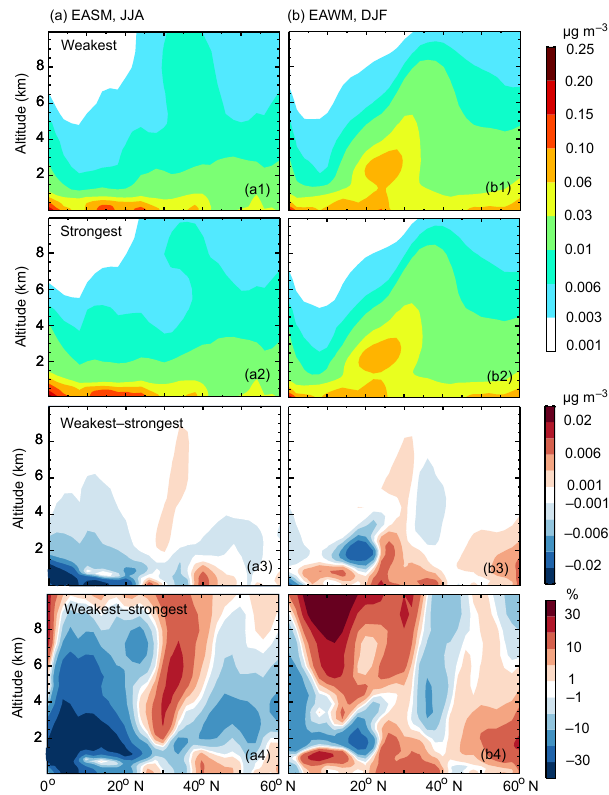
Figure 12. (a) Height–latitude cross sections of contributions of non-Chinese emissions to simulated JJA mean BC concentrations (µgm − 3 ) in the (a1) 5 weakest and (a2) 5 strongest EASM years during 1986–2006. Also shown are the (a3) absolute (µgm − 3 ) and (a4) percentage (%) differences between the 5 weakest and 5 strongest EASM years. Plots are averaged over a longitude range of 110–125 ◦ E from model simulation VMET. (b) Same as (a) , but for simulated DJF mean BC concentrations in the 5 weakest and 5 strongest EAWM